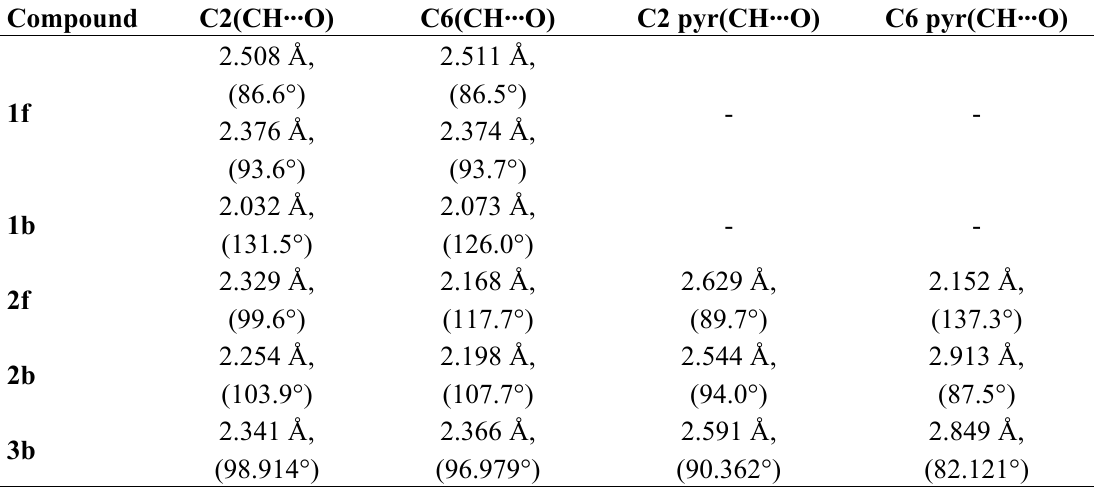
Table 3. Comparison of H-bond parameters in model compounds 1f , 1b and 2b , 2f and 3b .